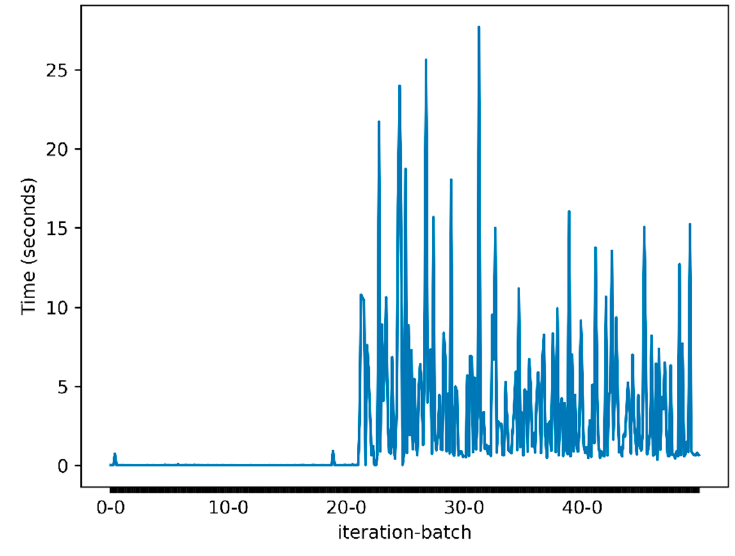
Figure 7. Execution